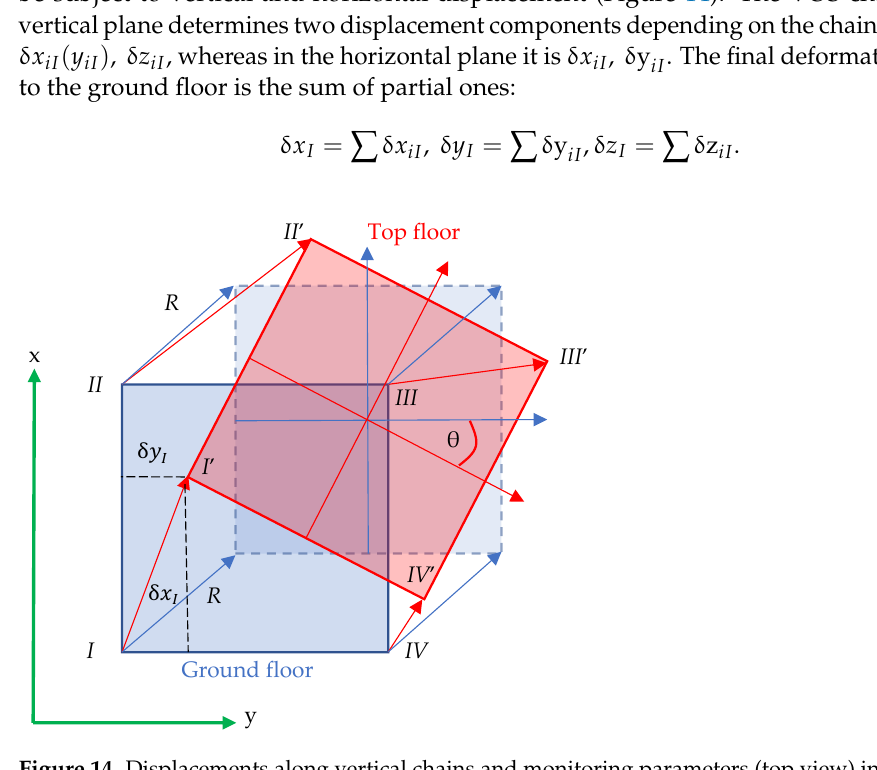
Figure 14. Displacements along vertical chains and monitoring parameters (top view) in the hori- zontal plane.